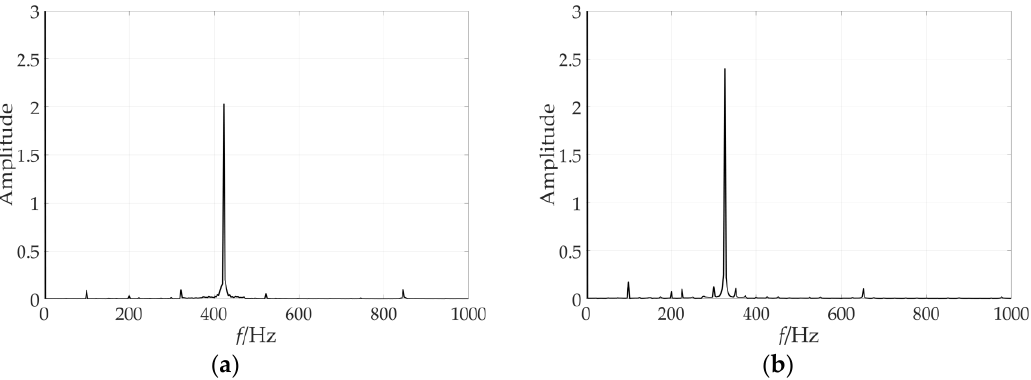
Figure 6. Waveform of u pv when ( a ) K p 1 = 0.11, T i 1 = 0.001; ( b ) K p 1 = 0.05, T i 1 = 0.001.